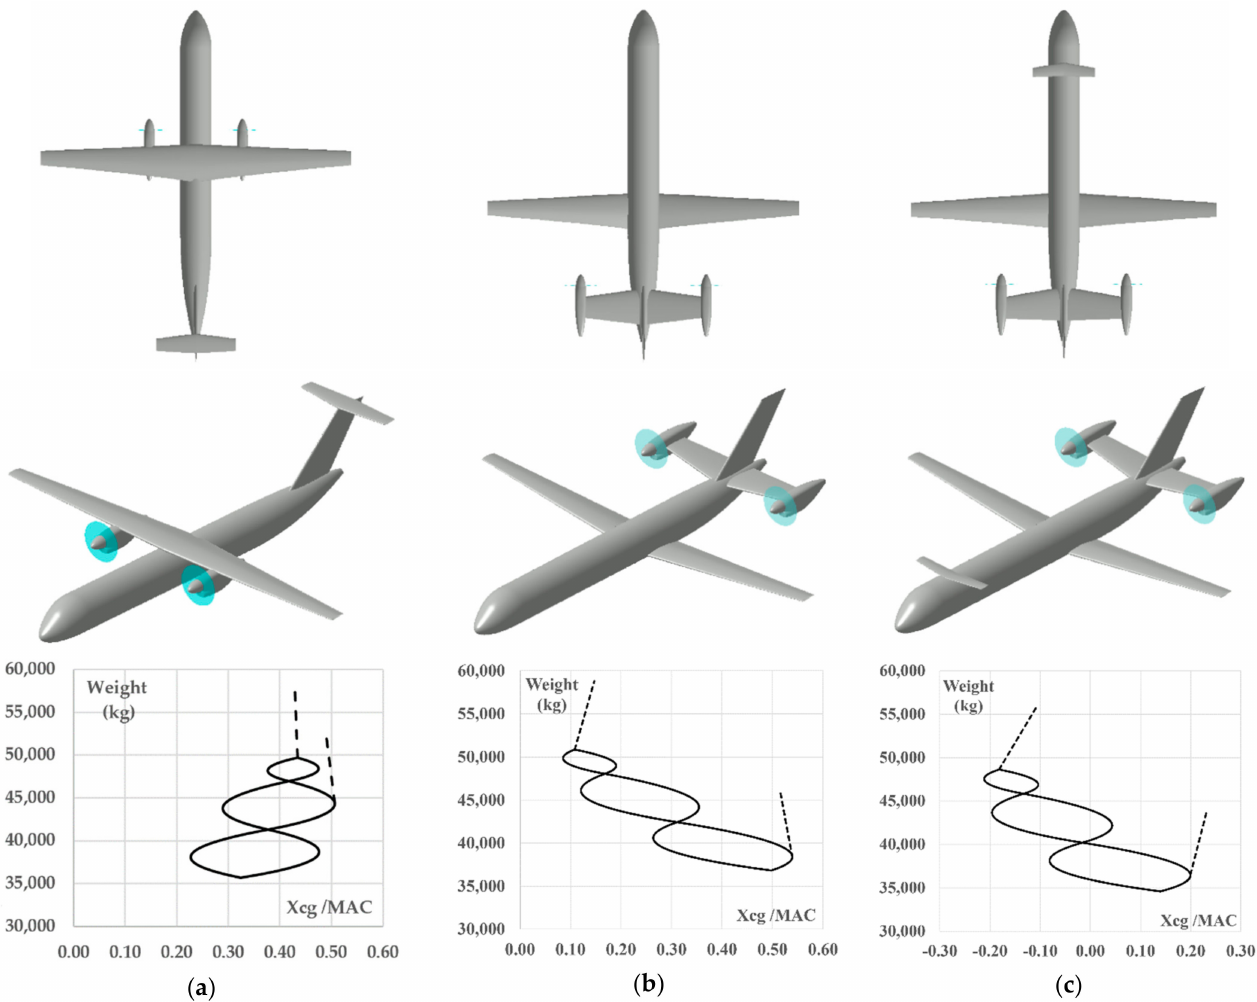
Figure 13. Selected optima solutions for each aircraft configuration: ( a ) optimized high wing with under wing-mounted engines configuration and its boarding diagram; ( b ) optimized low wing with rear-mounted engines configuration and its boarding diagram; and ( c ) optimized three-lifting-surface with rear-mounted engines configuration and its boarding